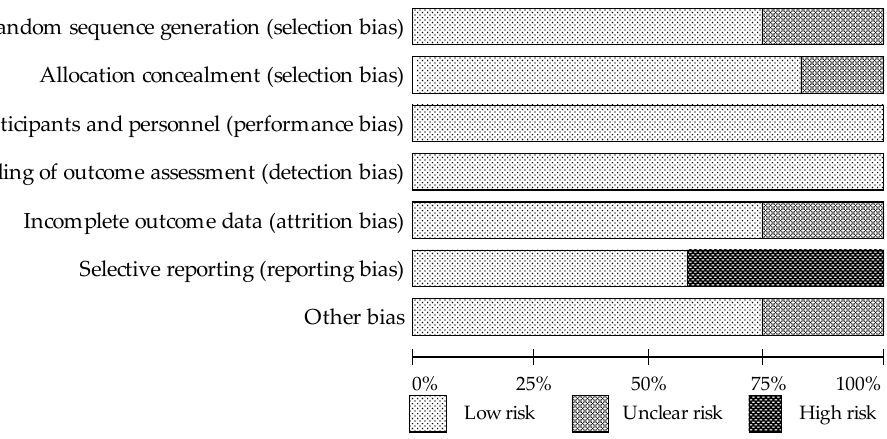
Figure 2. Risk of bias summary for each study as assessed by the authors [33–44].